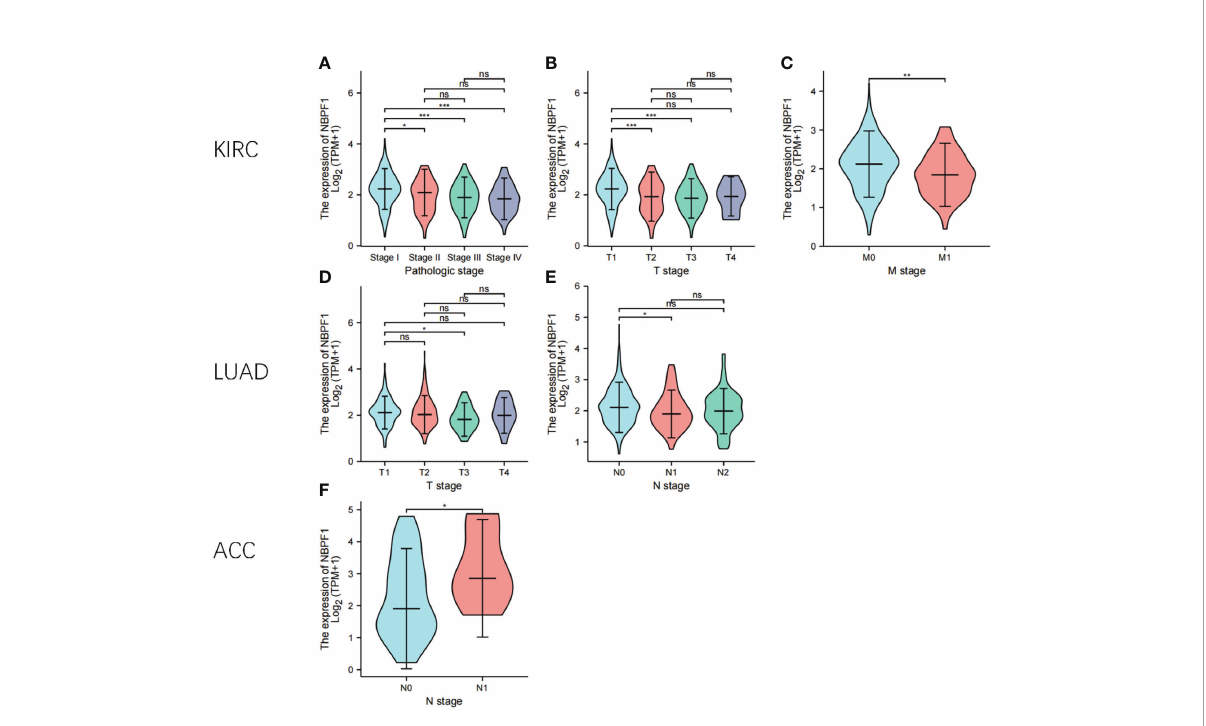
FIGURE 3 The expression levels of NBPF1 in tumors with different pathological stages. (A – F) The pathological stage-dependent expression levels of NBPF1 (*P < 0.05; **P < 0.01; ***P < 0.001) ns, no signi fi cant